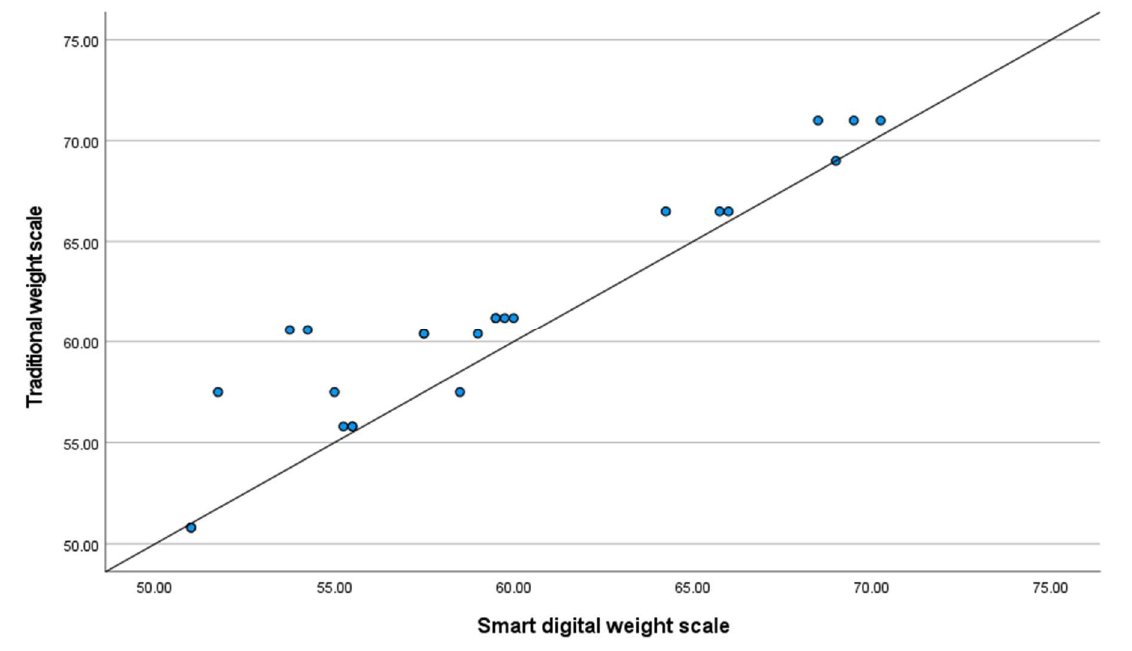
Figure 7. Scatterplot of the weight measured by traditional mechanical weight scale against smart digital weight scale.